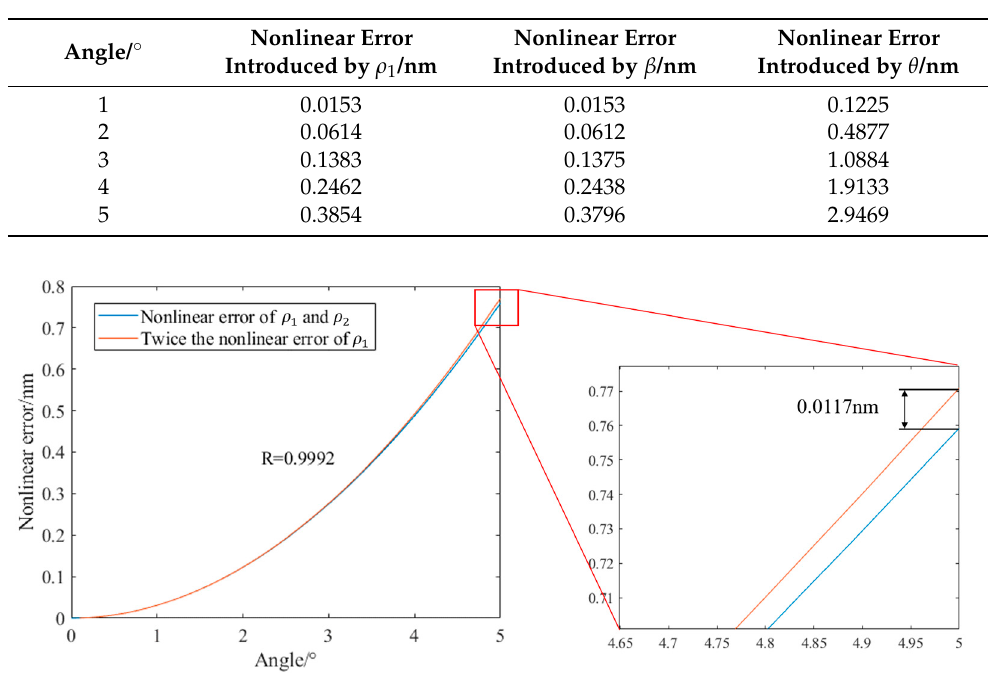
Table 2. Nonlinear errors introduced by various in fl uencing factors.